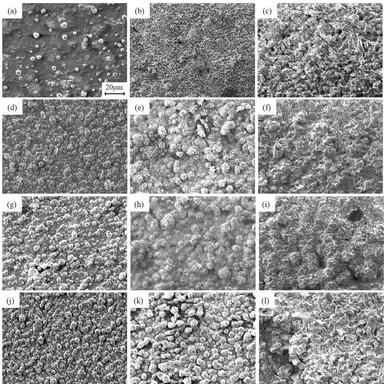
SEM micrographs of TiCXN1-X-TiCrNbMoTa composites after exposure at 1273 K in the atmosphere (a) X = 0, 30 min (b) X = 0, 2 h (c) X = 0, 12 h (d) X = 0.5, 30 min (e) X = 0.5, 2 h (f) X = 0.5, 12 h (g) X = 0.7, 30 min (h) X = 0.7, 2 h (i) X = 0.7, 12 h (j) X = 1.0, 30 min (k) X = 1.0, 2 h (l) X = 1.0, 12 h.